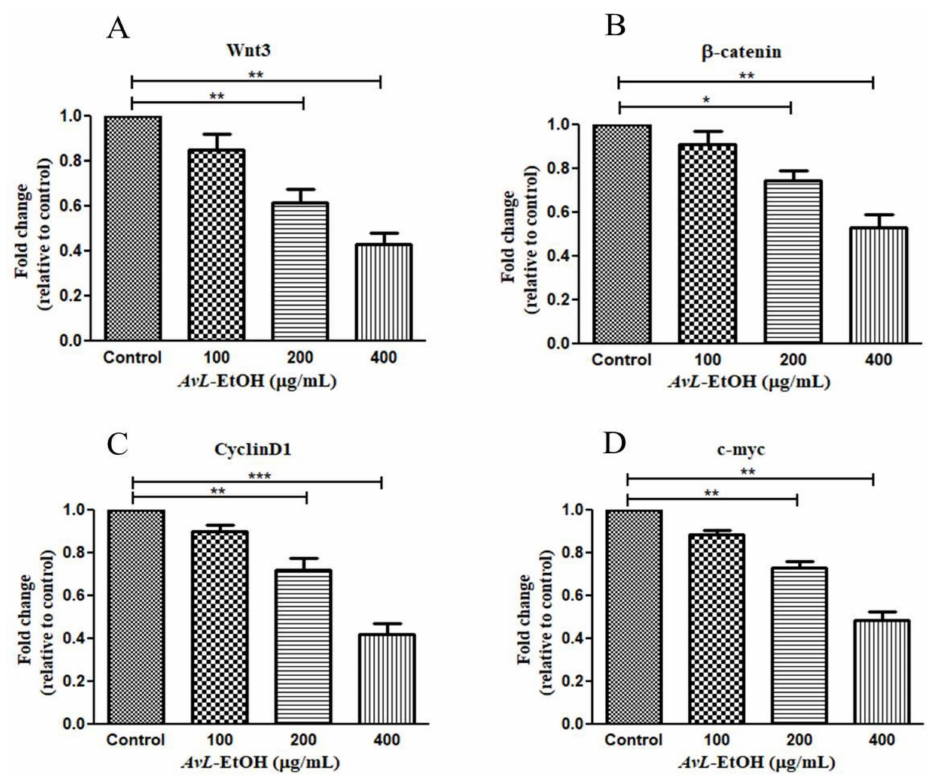
Figure 12. Effect of AvL -EtOH on Wnt signaling pathway and its downstream target genes. AvL - EtOH treatment inhibited the mRNA expression level of ( A ) Wnt3, ( B ) β -catenin, ( C ) cyclin D1 and ( D ) c-Myc in A549 NSCLC cells. * p < 0.05, ** p < 0.01 and *** p <